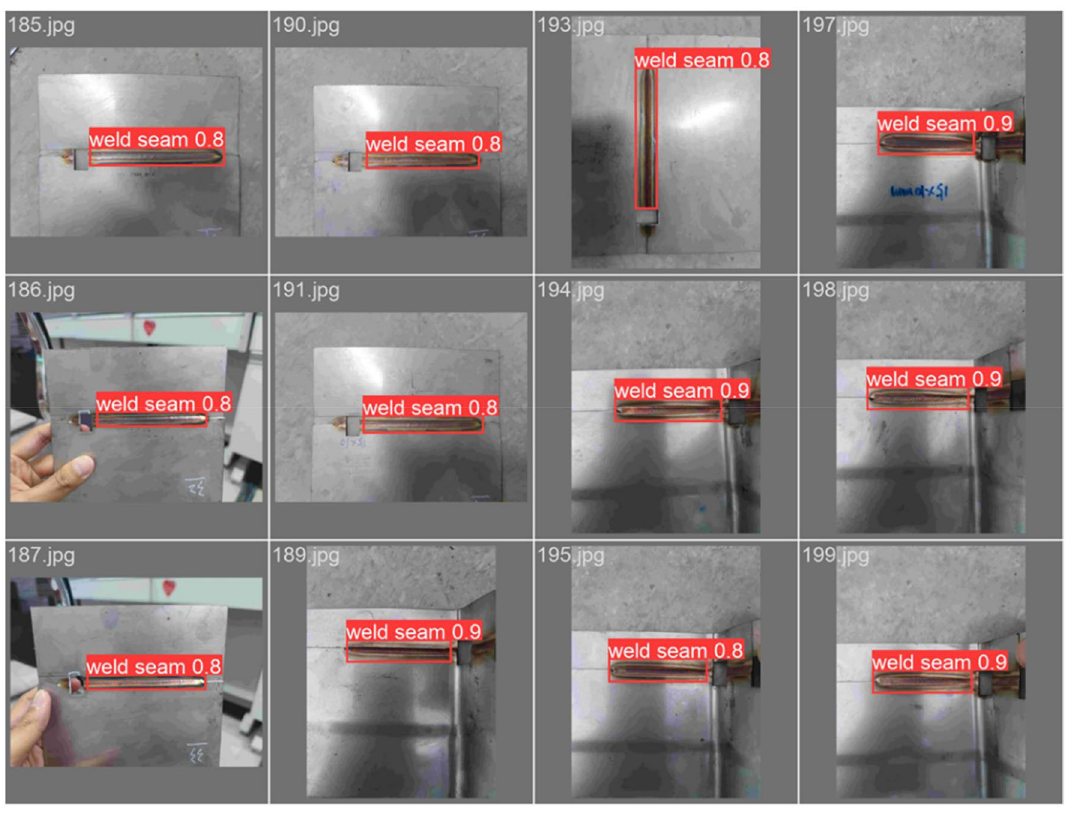
Figure 17. Welding seam test